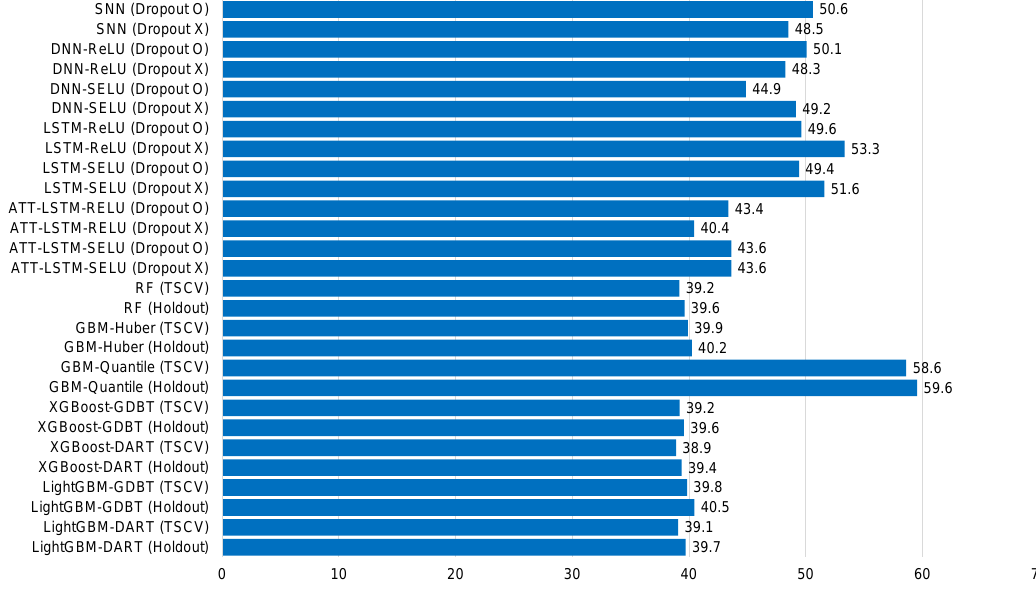
Remote Sens. 2020 , 12 , x FOR PEER REVIEW Figure 13. Average normalized root mean square error for each model for Gosan-ri ( % ). Month